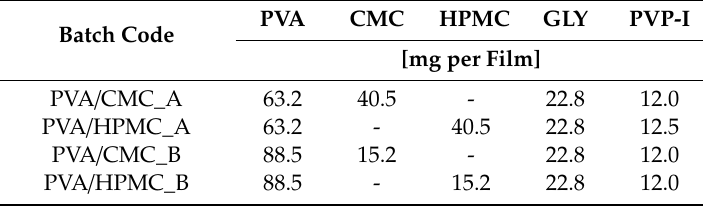
Table 1. Composition of fabricated films. PVA, polyvinyl alcohol; CMC, carboxymethylcellulose sodium salt; HPMC, hydroxypropyl methylcellulose; GLY, glycerol; PVP-I,